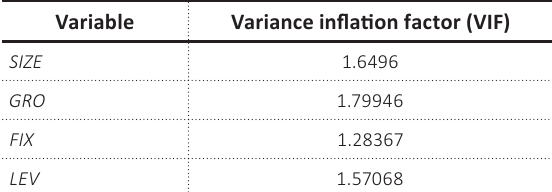
Table 4. Multicollinearity analysis